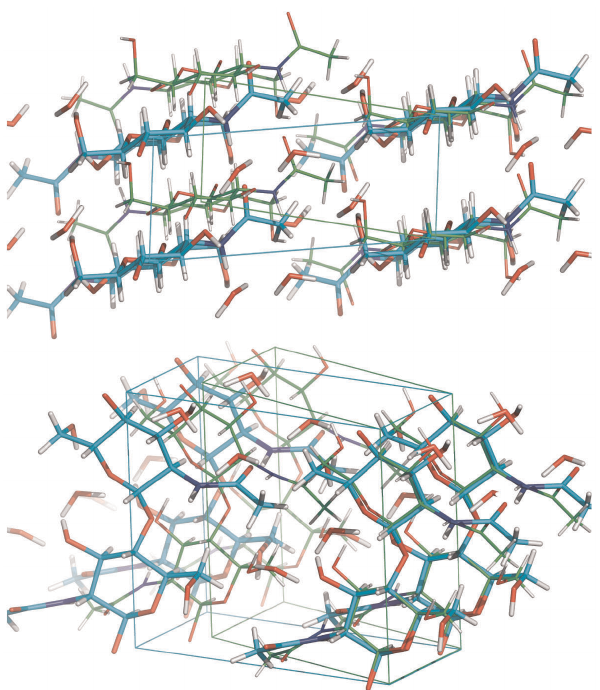
Figure 1. Superposition of dihydrate b -chitin (cyan backbone and cell) and anhydrous structure